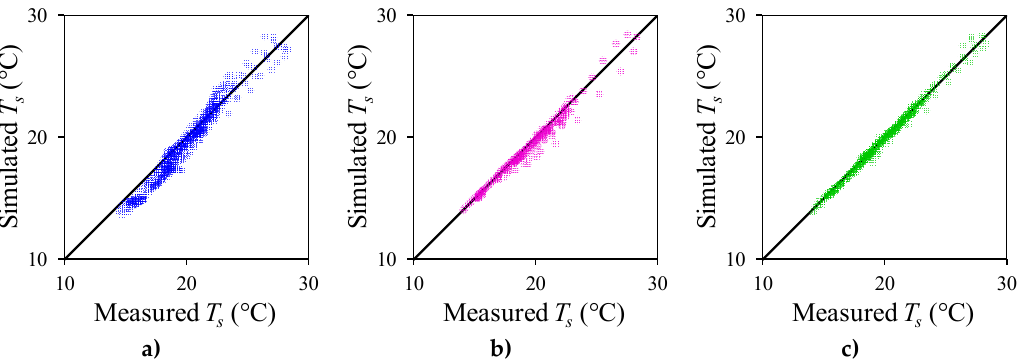
Figure 6. Comparison of the measured and the simulated soil temperature by (a) Newton’s law of cooling, (b) HYDRUS-1D, and (c) the random forest model. The straight slash is a 1:1 line. Table 2. Root mean square errors (RMSEs) and Nash-Sutcliffe model efficiency coefficients (NSEs) of the model simulations.